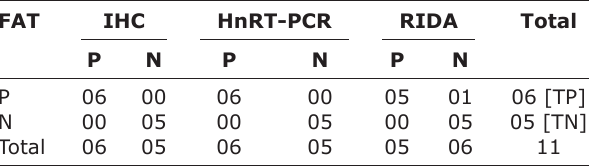
Table-2: Test results of IHC, HnRT-PCR and RIDA in comparison with FAT. FAT